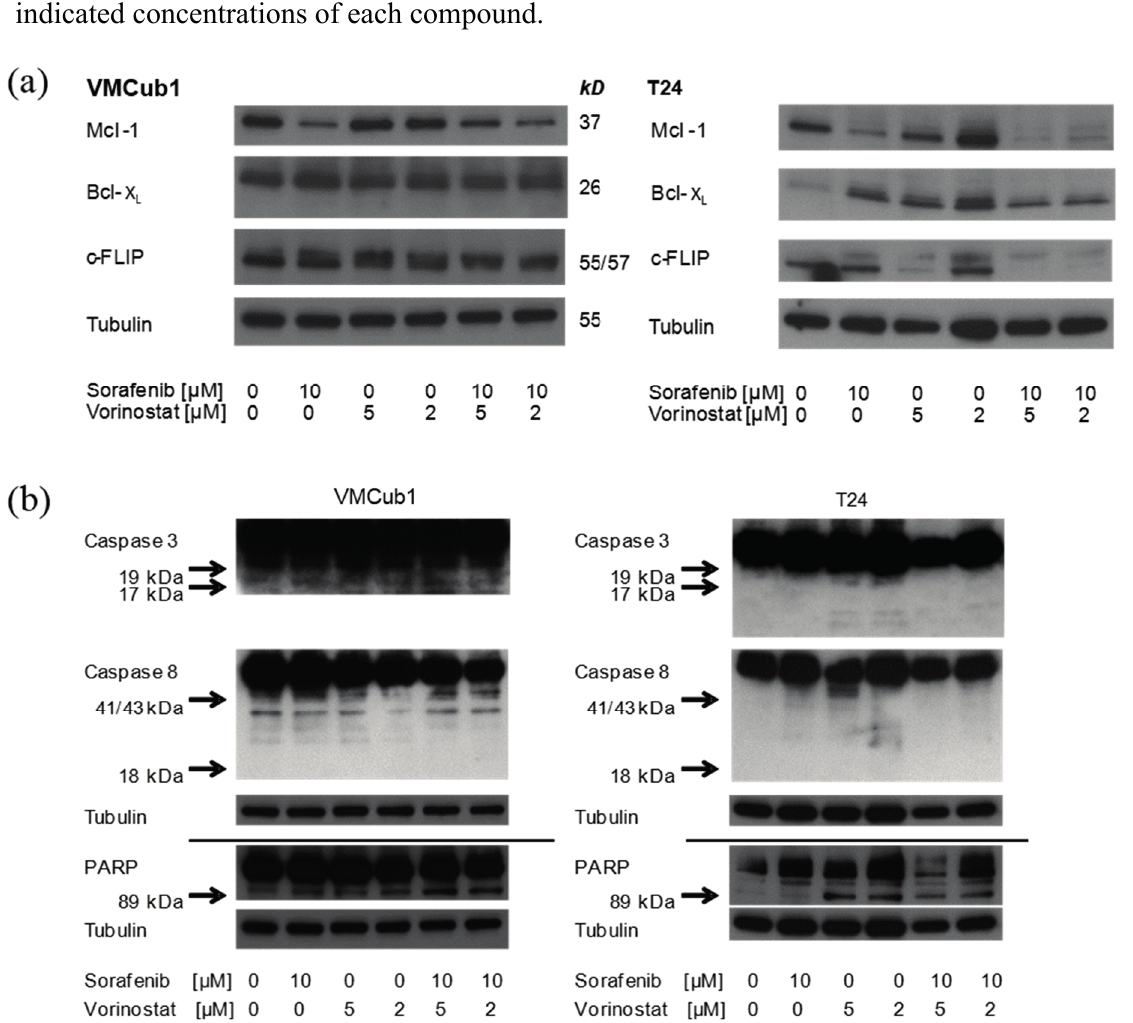
Figure 5. ( a ) Effects of sorafenib, vorinostat, and the combination of both compounds on anti-apoptotic factors myeloid cell leukemia 1 (Mcl-1), B-cell lymphoma-X L (Bcl-X L ),